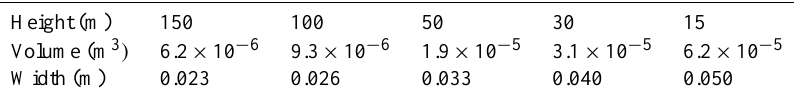
Table 1. Minimal volume and corresponding width to consider for a rock compartment reaching a wall foot with a minimal kinetic energy of 0.025 kJ, as a function of the detachment height.